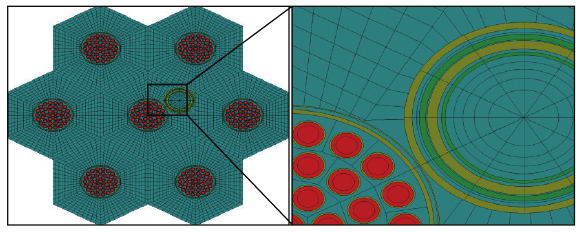
Figure 4: CNA II control rod model (left) and a close-up of the control rod section (right).